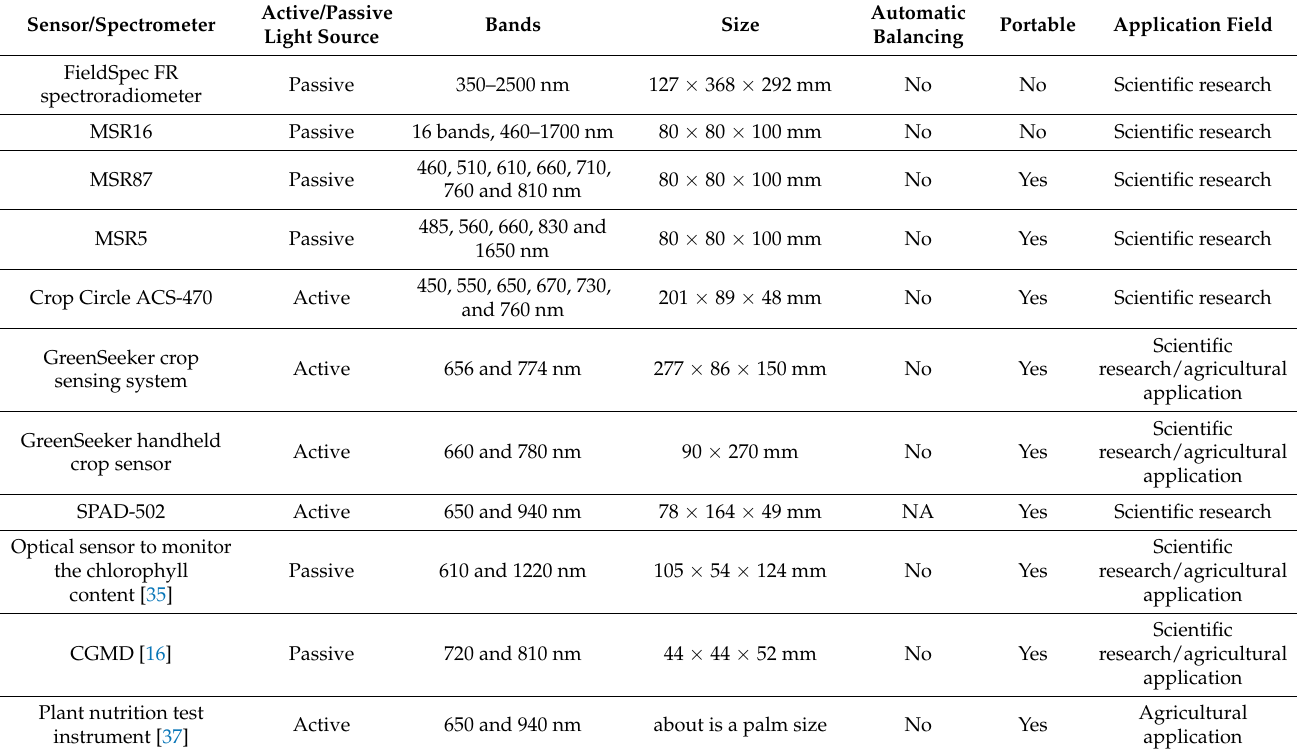
Table 1. The characteristics of selected